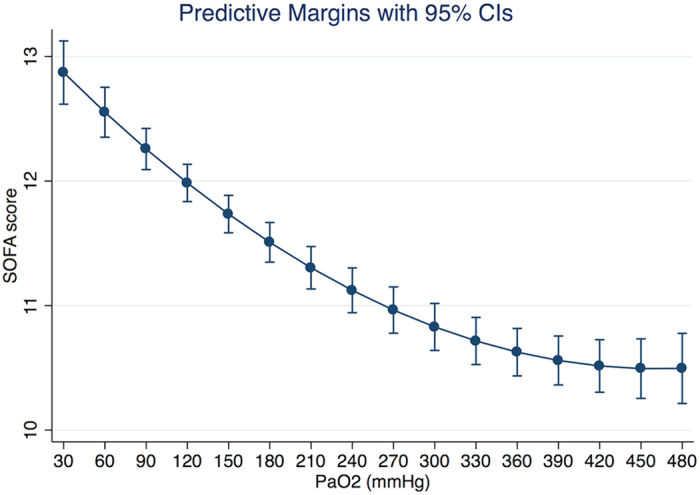
Marginal effect of PaO2 on SOFA score after adjustment for other covariates (all variables finally remained in the model).The SOFA score decreased monotonously with increasing PaO2 before 450 mmHg. After that further increase in PaO2 has no effect on reducing SOFA.